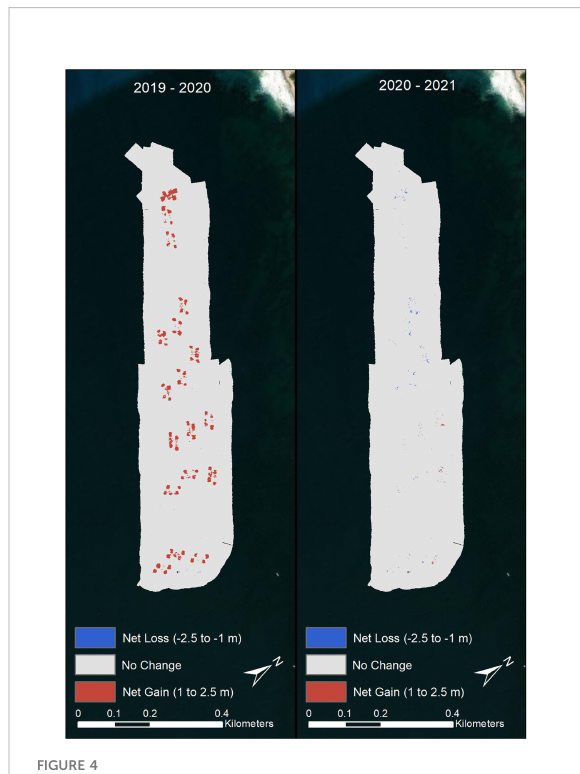
FIGURE 4 Year-to-year difference in bathymetry of the restoration area, including the 18 modules of Palos Verdes Reef. Blue and red indicate deeper and shallower sea fl oor, respectively, as compared to the previous year. Gray areas indicate a change of less than 1